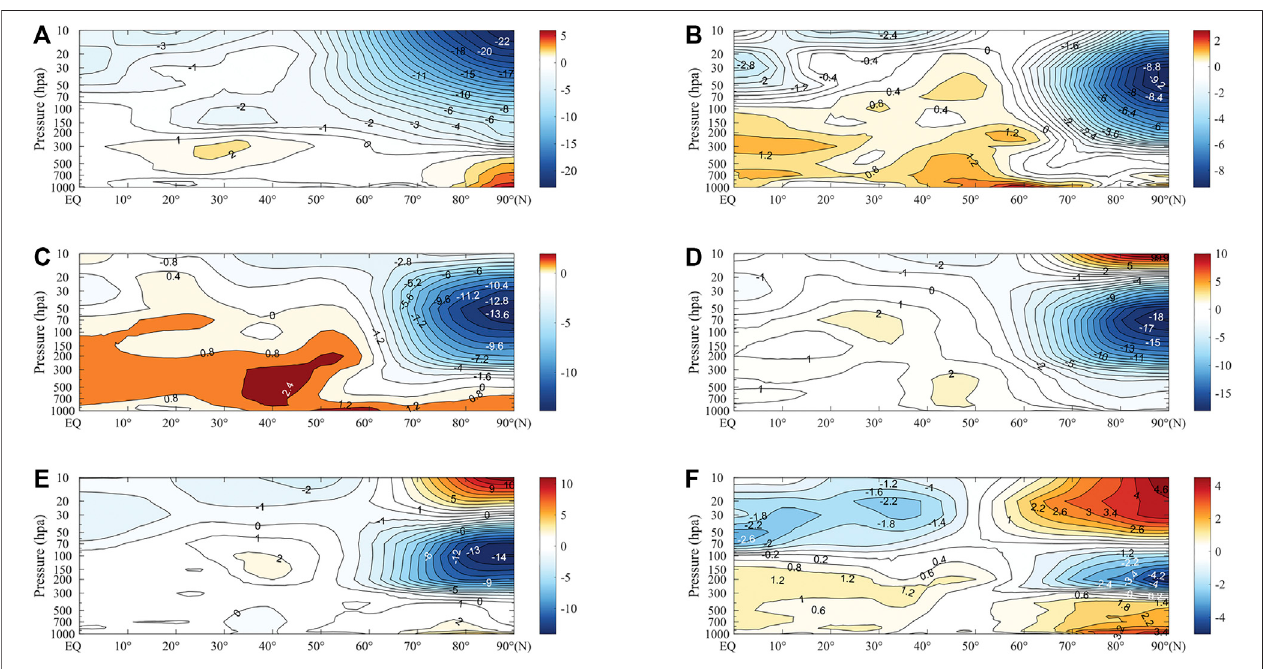
FIGURE6| Monthlyverticalpro fi le ofthezonal-average temperature intheNorthernHemispherein (A) December 2019, (B) January2020, (C) February2020, (D) March 2020, (E) April 2020, and (F) May 2020.